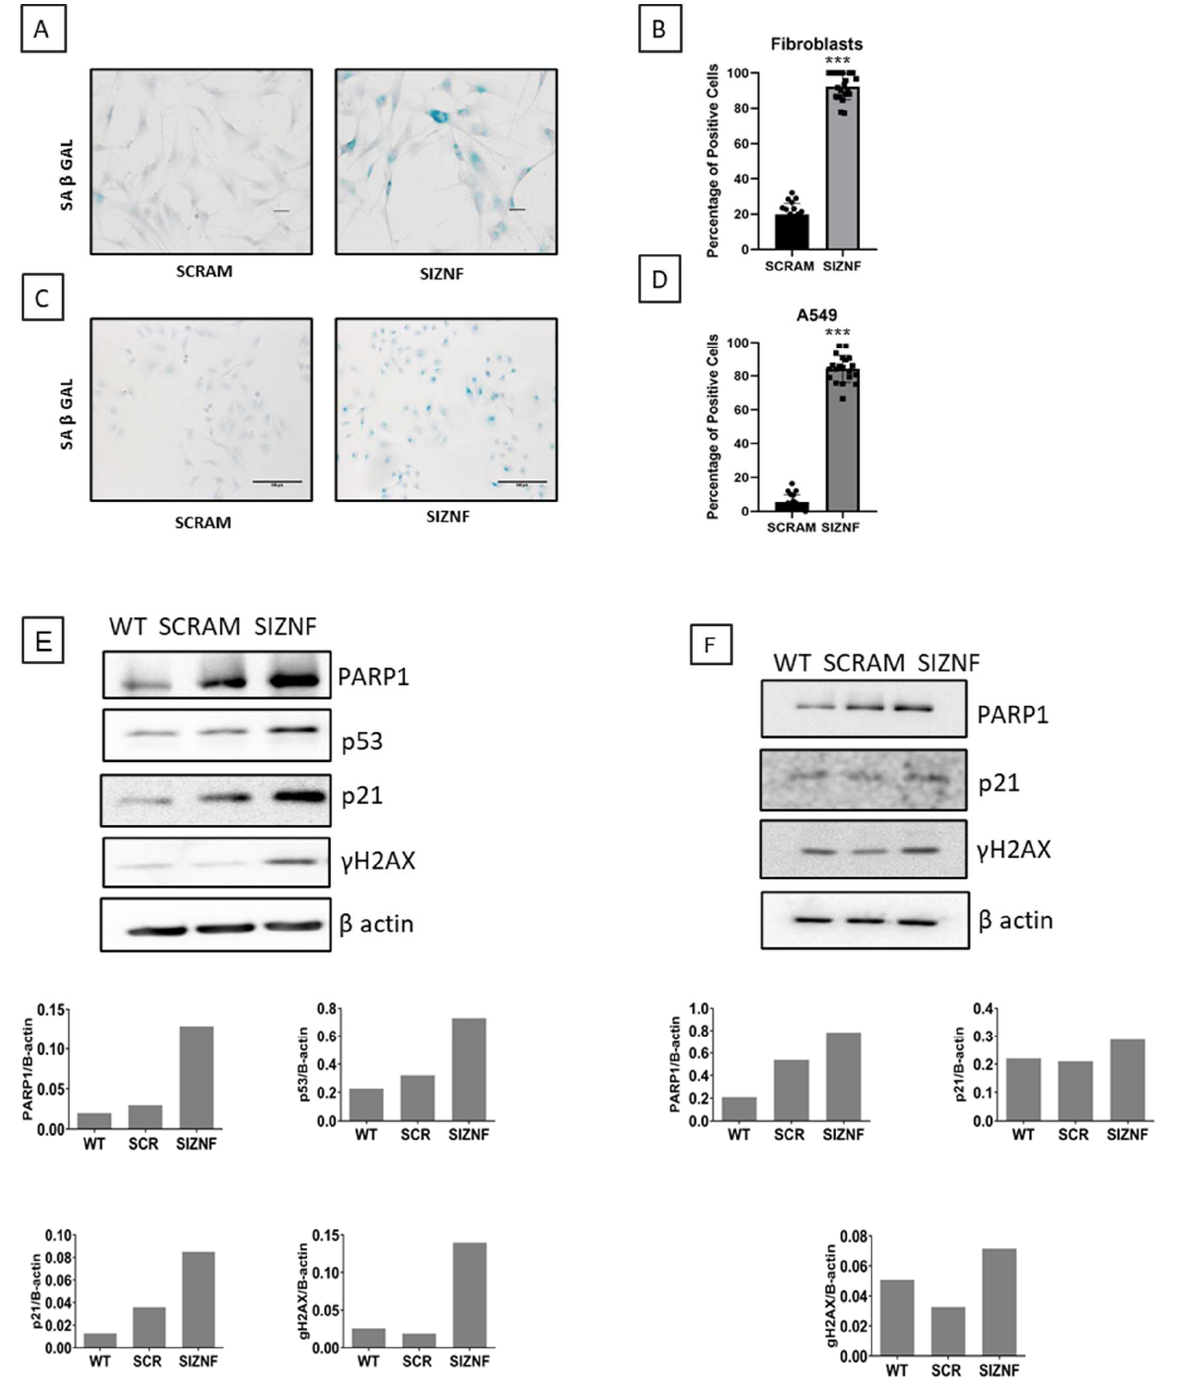
Figure 6. Normal human lung fibroblasts and A549 cells acquire a senescent phenotype after ZNF365 silencing. Senescence-associated β galactosidase activity (SA-β Gal) staining photomicrograph of normal human lung fibroblasts ( A ) and A549 epithelial cells ( C ) transfected with scrambled control sequences “SCRAM” or with specific siRNA sequences for ZNF365 “siZNF” (Scale bar 100 μm). ( B , D ), Percentage of positive SA-β Gal staining. Western blot analysis of senescent markers in ZNF365 silenced normal human lung fibroblasts ( E ) and A549 cells ( F ); β actin was used as the internal loading control. Densitometric analyses are shown. ( B , D ) graphics represent the mean ± SD of one experiment with two technical replicates and ten random bright microscopic fields counted for each replicate. *** p < 0.001 by a two-tailed Student’s t-test with Welch’s correction.